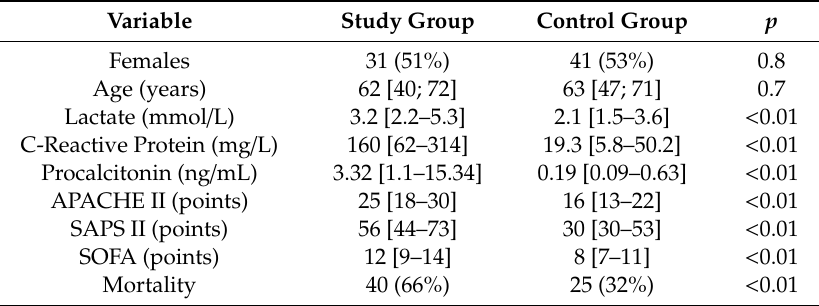
Table 1. Subjects’ basic characteristics.